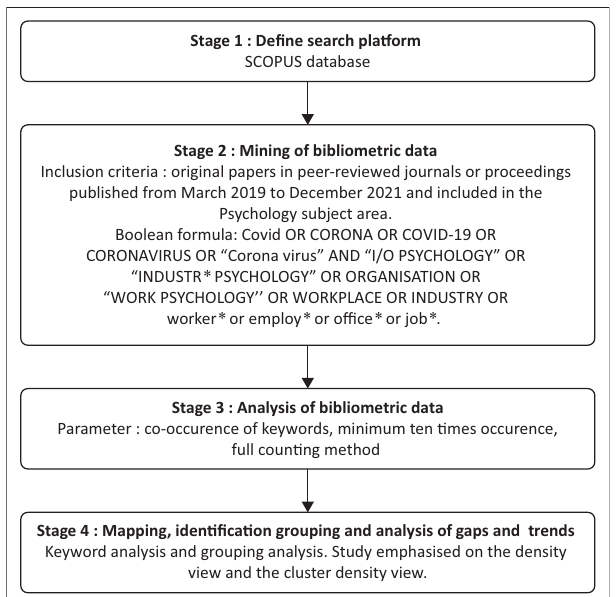
FIGURE 1: Stages for bibliometric analysis.